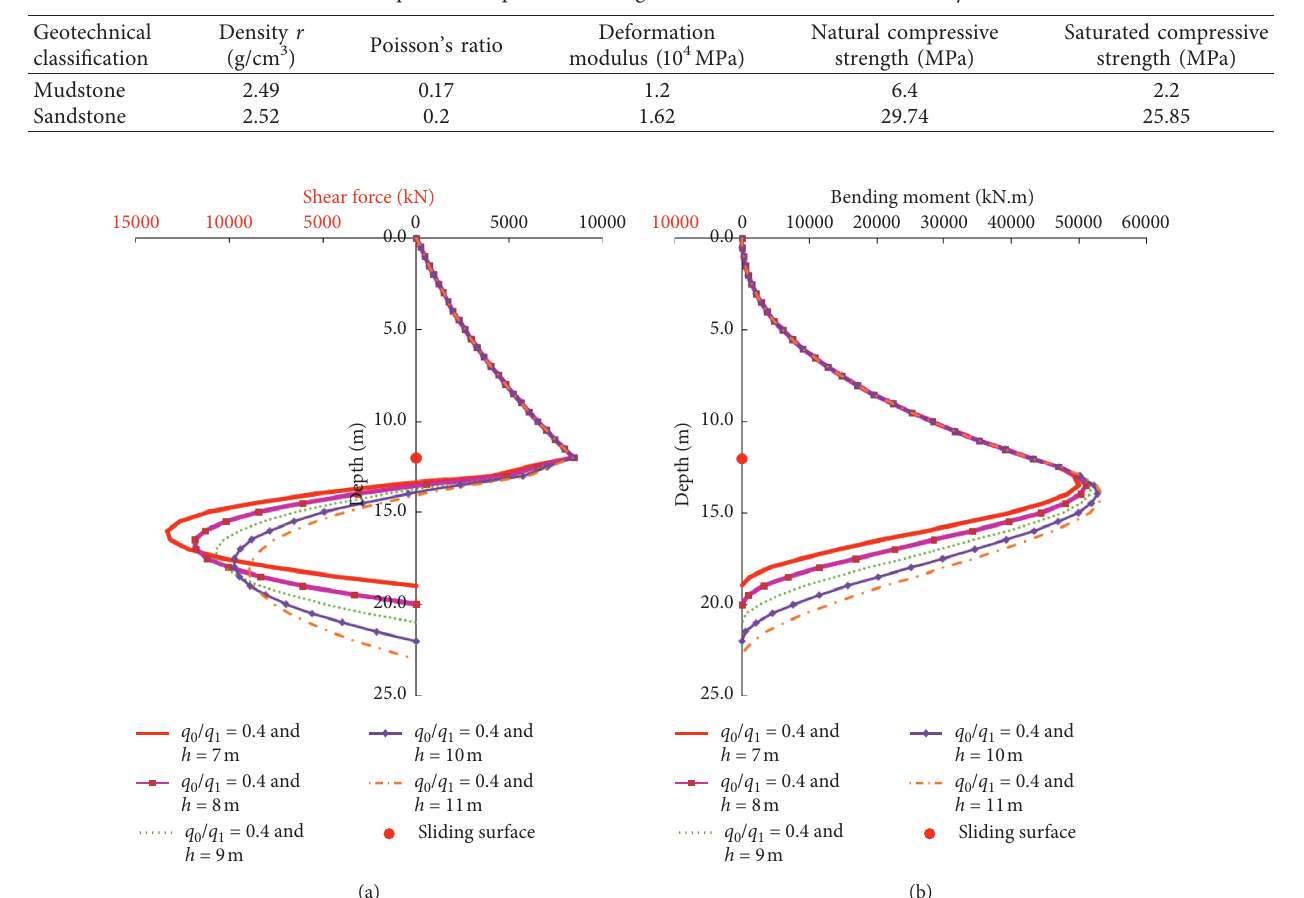
Table 2: Experimental parameters of geotechnical materials in the survey